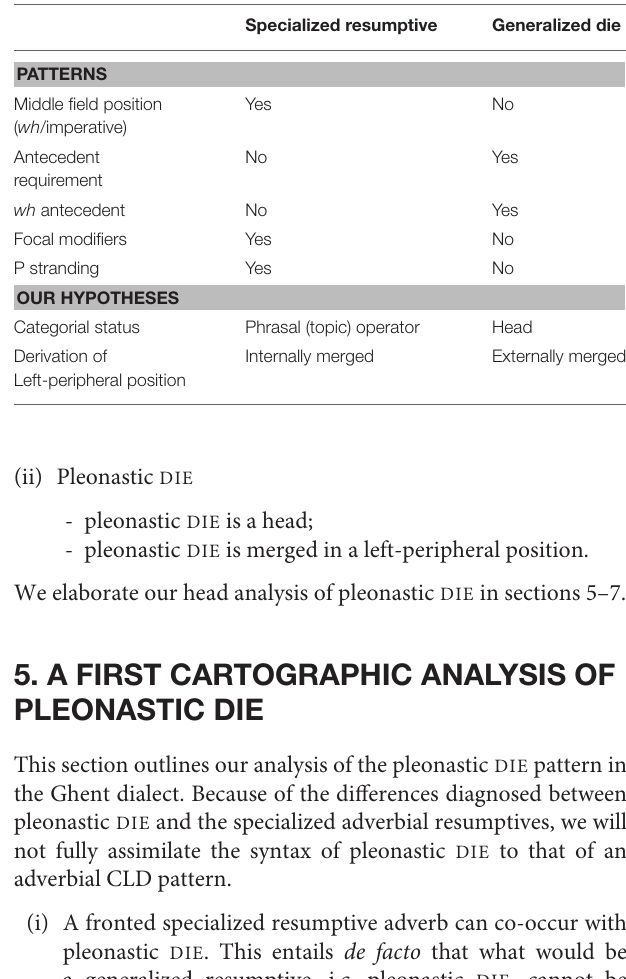
TABLE 1 | Specialized resumptive ( dan/tons/demonstrative pronoun ) vs. generalized DIE